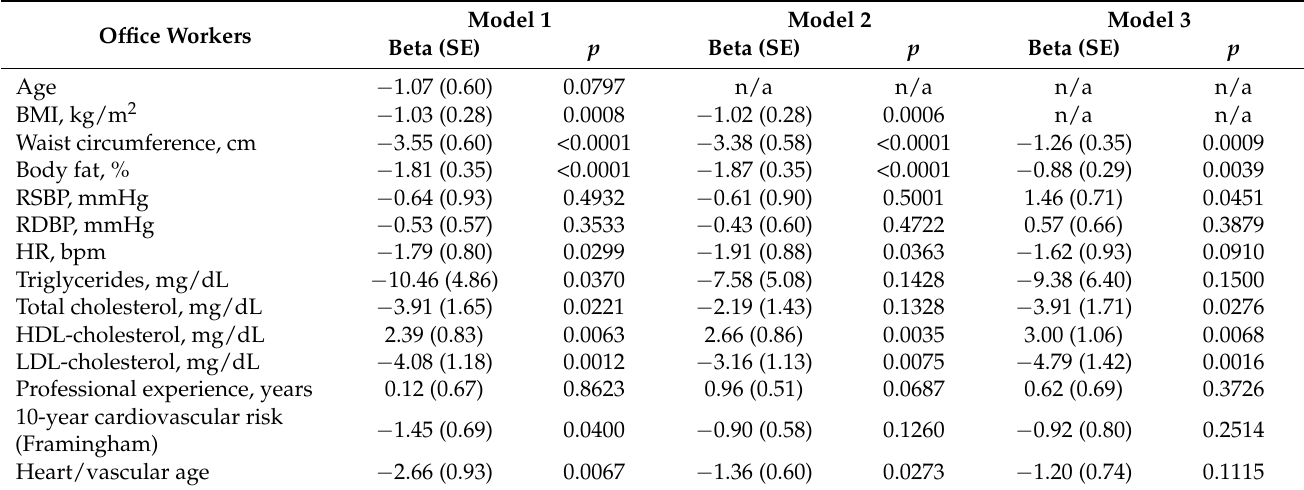
Table 5. Linear regression models of cardiovascular risk factors and METs as continuous variables for office